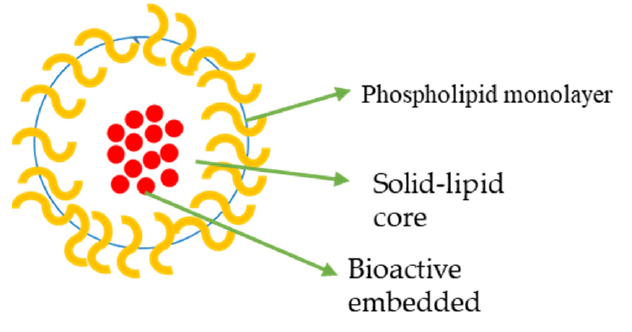
Figure 3. Solid Lipid Nanoparticle.